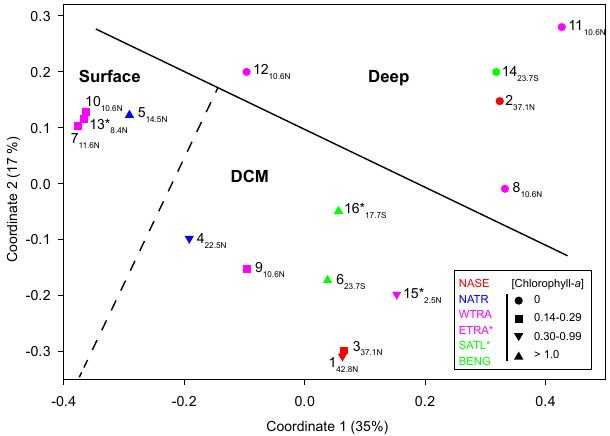
Fig. 5. Principal coordinate analysis (PCoA) of the normalized OTU abundances based on Bray-Curtis dissimilarity. Each individ- ual sample is identified by its respective biogeographic province (symbol color) and Chl a concentration in mgl − 1 (symbol shape). Each numerical identifier corresponds to a different sample (1–16) with the latitude of the sampling location as a subscript in the leg- end. The first three coordinates of the PCoA explained 65% of the variance in the community data (coordinate 1: 35%, 2: 17%, and 3: 13%). The solid line represents the separation above and below the pycnocline, and the dashed line separates photic zone samples into surface and DCM